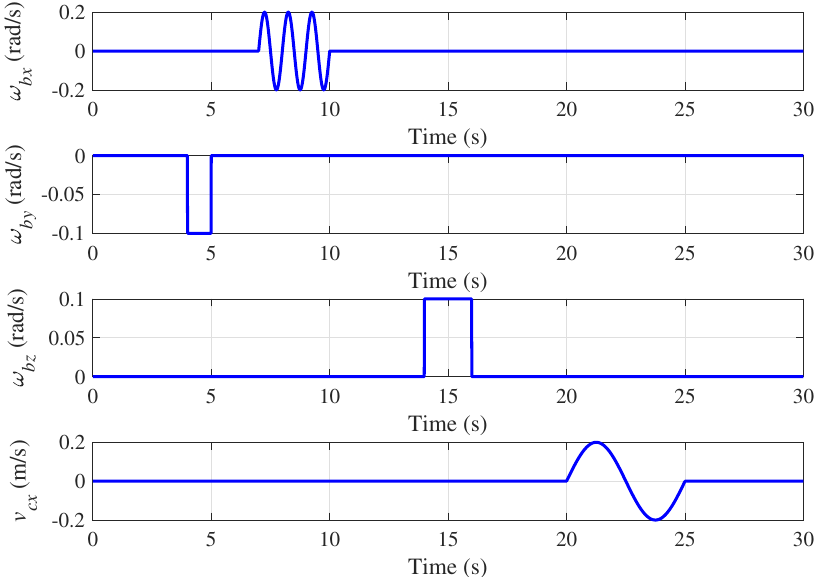
Figure 10. Carrier disturbing angular velocity and target moving velocity in numerical simulations. In order to validate the superior performance of the vision-based tracking controller, comparative numerical simulations between the proposed controller and the cascaded PID controller are conducted. The sampling time of numerical simulations is 0.01 s. The simulation results of the proposed controller and the cascaded PID controller are depicted by solid blue line and dashed green line, respectively. For avoidance of the chatter generated by the signum function in (25), we replace sgn ( e ) with a saturation function sat ( e / B ) , where B is the boundary layer thickness. The trajectories of horizontal and vertical tracking errors in the image pixel coordinate frame are illustrated in Figure 11. When the miniature quadrotor UAV has a disturbing angular velocity ω bz with respect to the body coordinate from 14 s to 16 s, and the target moves with a sinusoidal translational velocity v cz from 20 s to 25 s in the simulations, the maximum horizontal tracking error u is within ± 10 px for the proposed controller, and it is within ± 30 px for the cascaded PID controller. Moreover, it can be seen that the horizontal tracking error u of the proposed controller is driven to 0 at last in the simulations, and the convergence speed is obviously faster than that of the cascaded PID controller. Therefore, we can conclude that the disturbance rejection ability and tracking performance of the proposed controller are better than those of the cascaded PID controller in the presence of carrier disturbance and target movement. The normalized control inputs of the azimuth axis and elevation axis are provided in Figure 12. It can be seen that the changes of the control inputs are milder than those of the cascaded PID controller, and they are all with reasonable